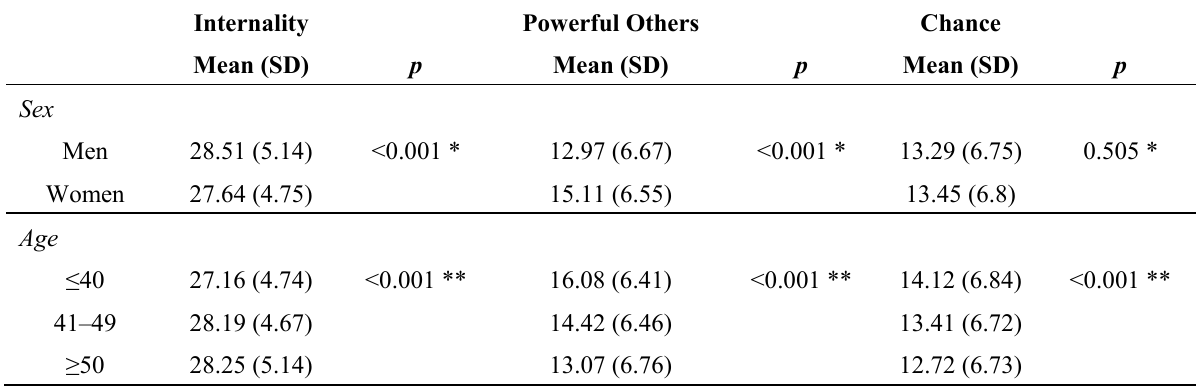
Table 4. Sex and age differences on IPC LOC Scale